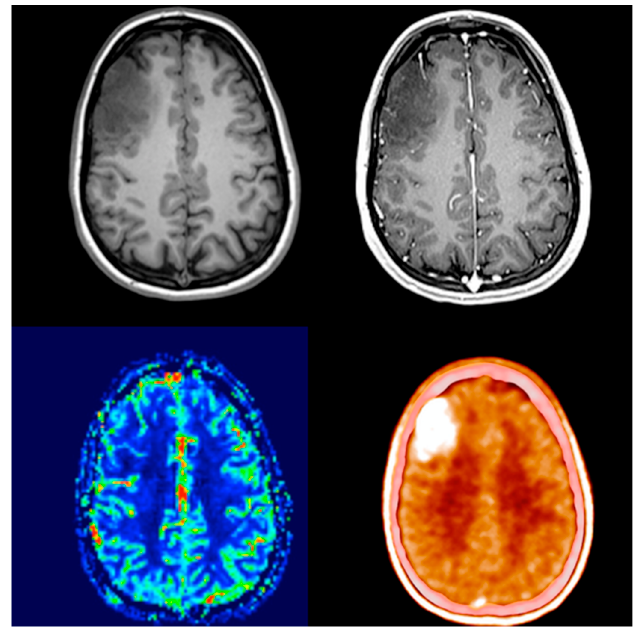
Figure 1. Thirty-two-year-old female with a right frontal non-enhancing mass known since the age of 14. Presenting for follow-up examination after 18 years of absence. The size of the lesion showed significant progression. Either contrast enhancement or elevated blood flow was present. PET/CT scan showed a smaller region and intense, well-circumscribed, nearly homogenous amino acid uptake (SUVmax: 4.95 vs. 1.57; TBRmax: 3.17). After surgical removal, histology revealed anaplastic oligodendroglioma with IDH mutation and 1p/19q co-deletion.